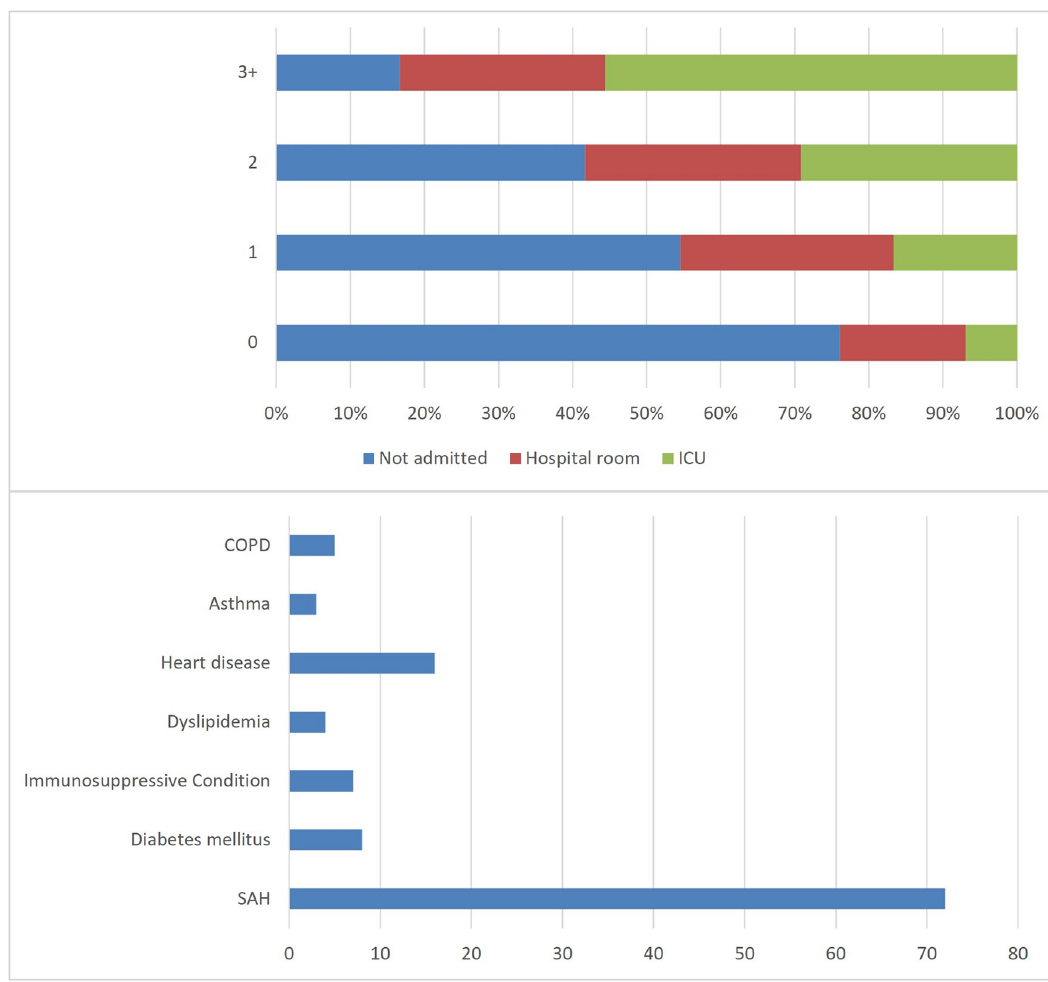
Fig 1. Distribution of comorbidities by area of hospitalization and its